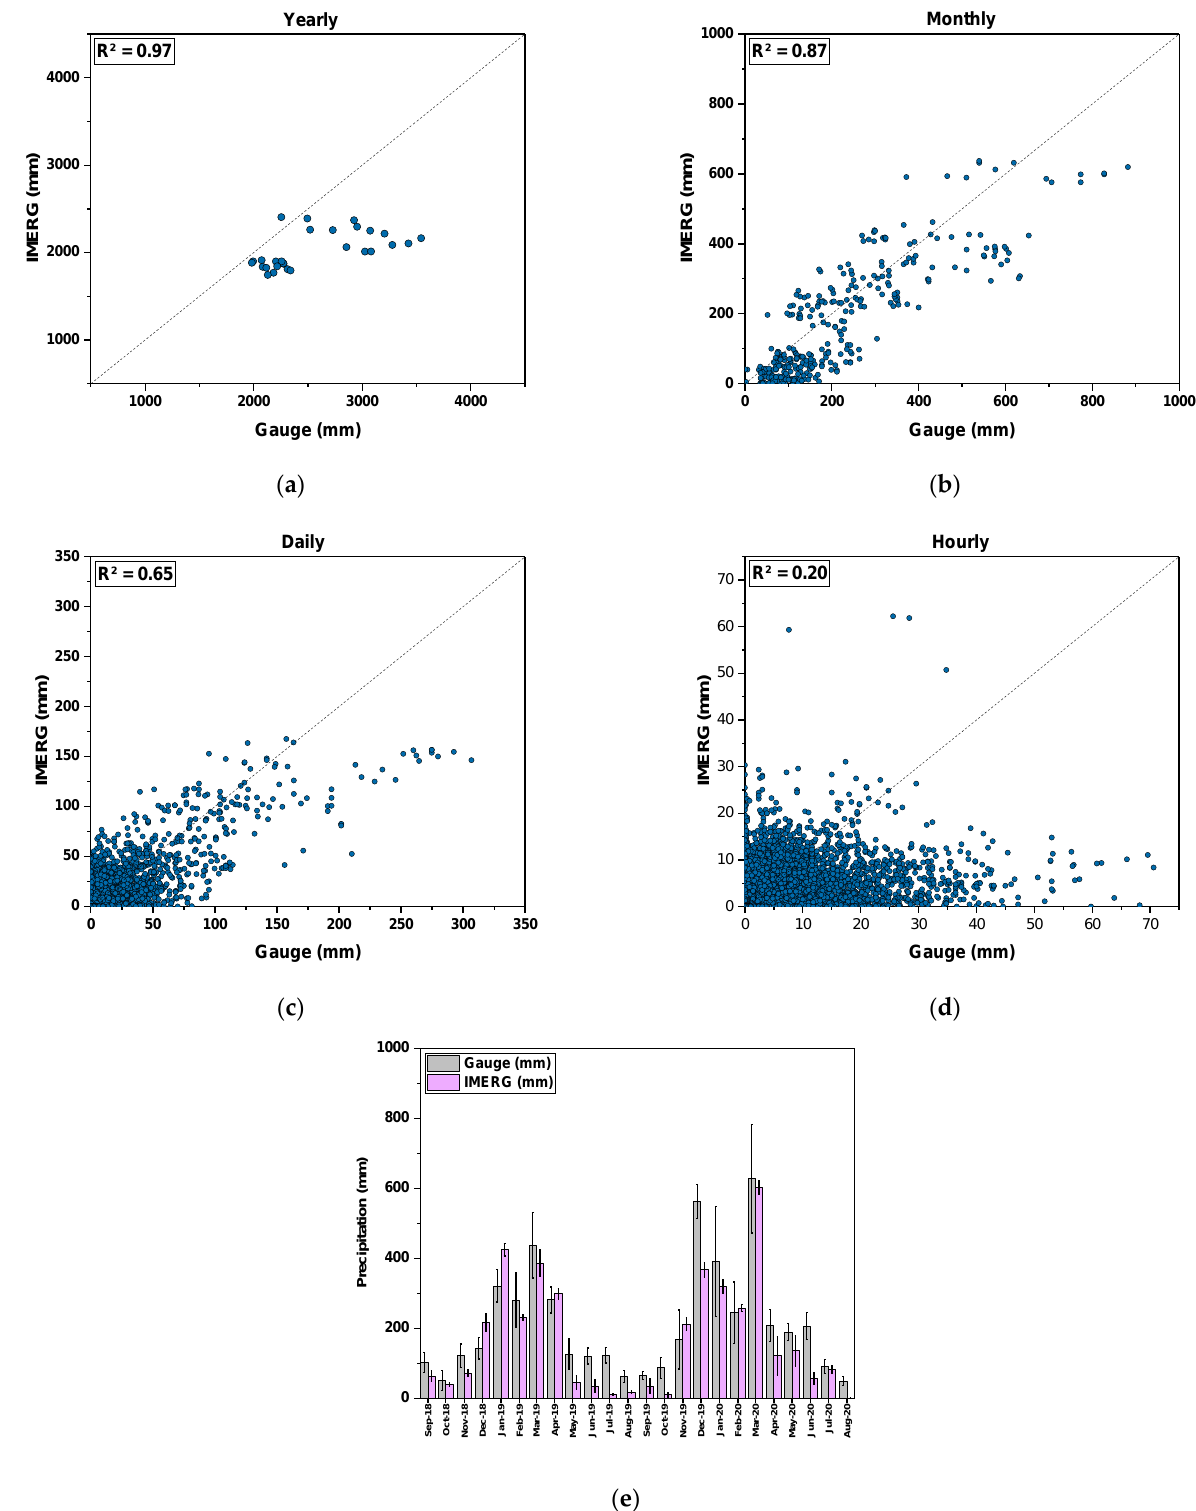
Figure 7. Comparison of ground-based precipitation data with IMERG at different time scales: ( a ) yearly, ( b ) monthly, ( c ) daily, ( d ) hourly, ( e ) barplot of monthly rainfall with standard deviation. R 2 value is determined for regression passing through (0,0).